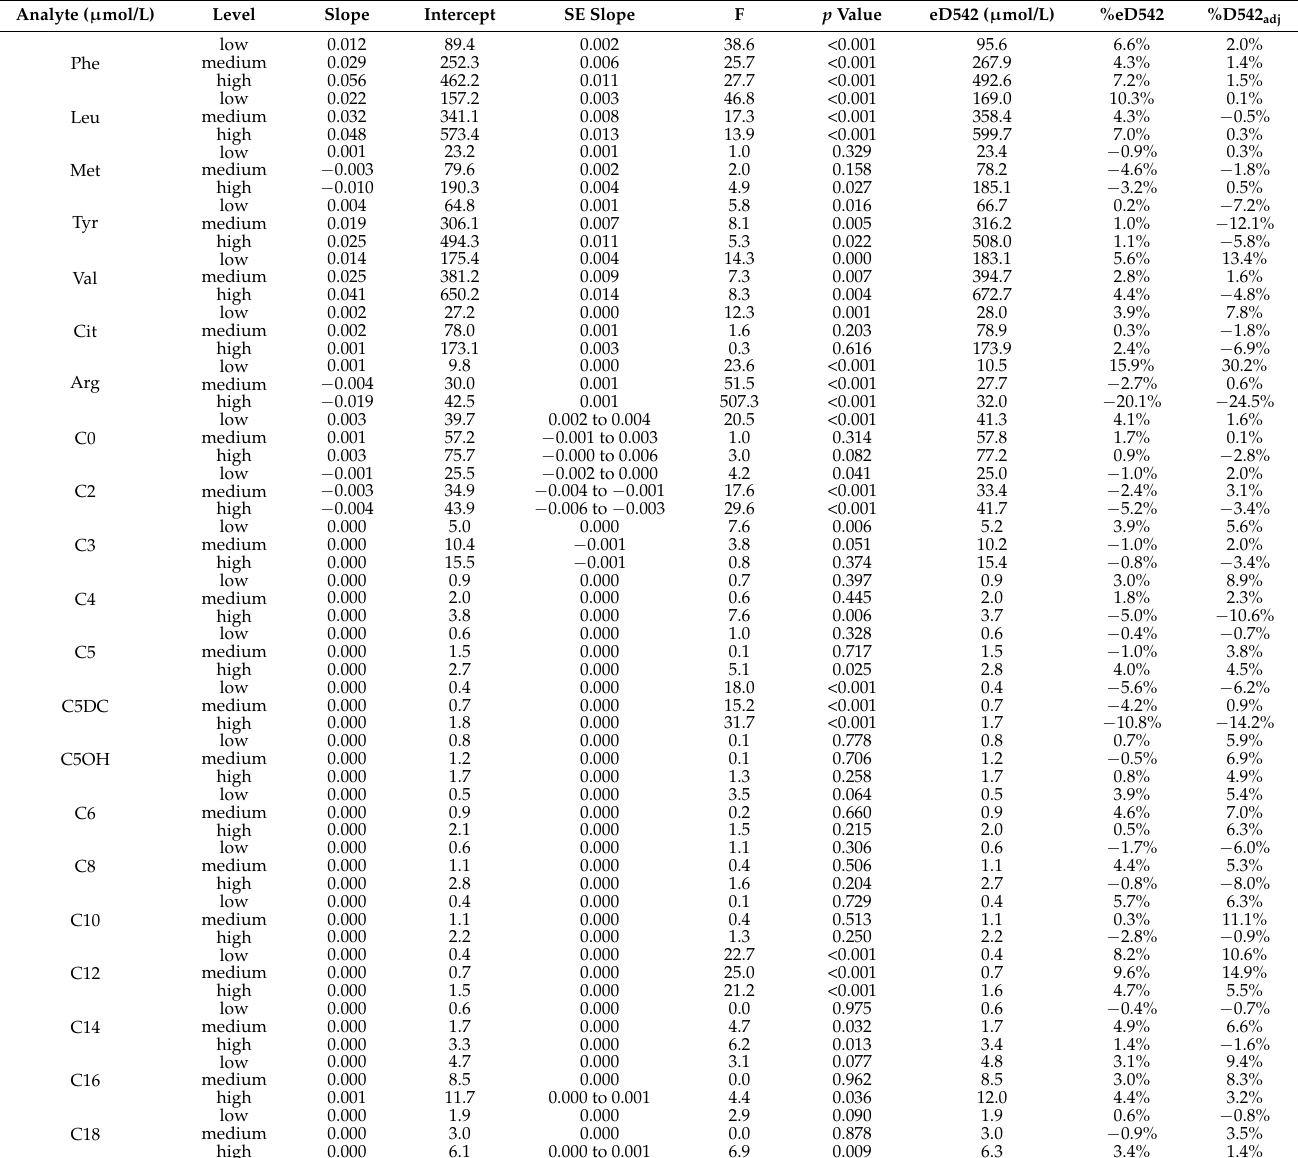
Table 2. The results of real-time stability analysis, using data obtained from D0 to